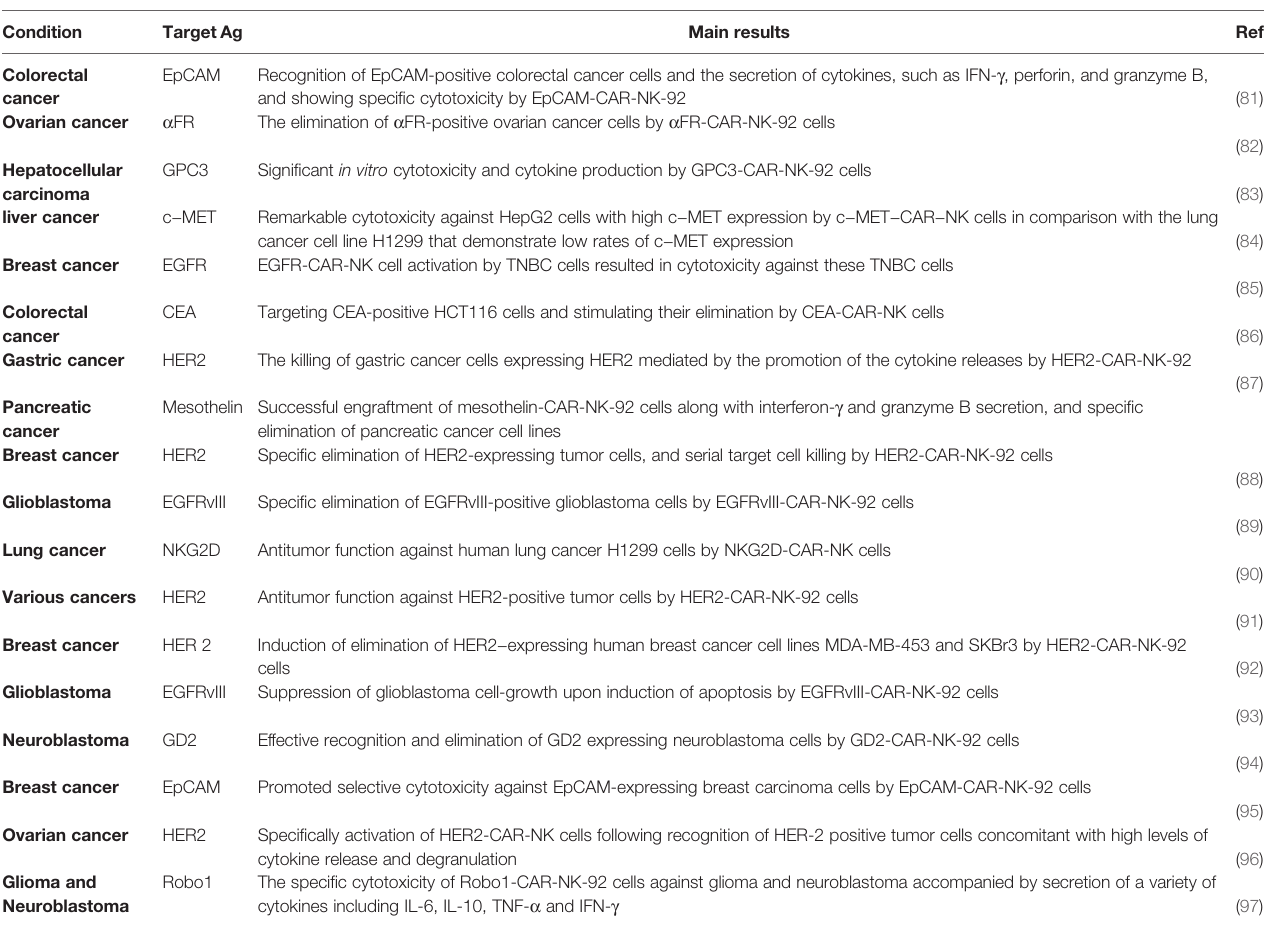
TABLE 1 | Overview of in vitro studies based on CAR-NK cell therapy for solid tumors.